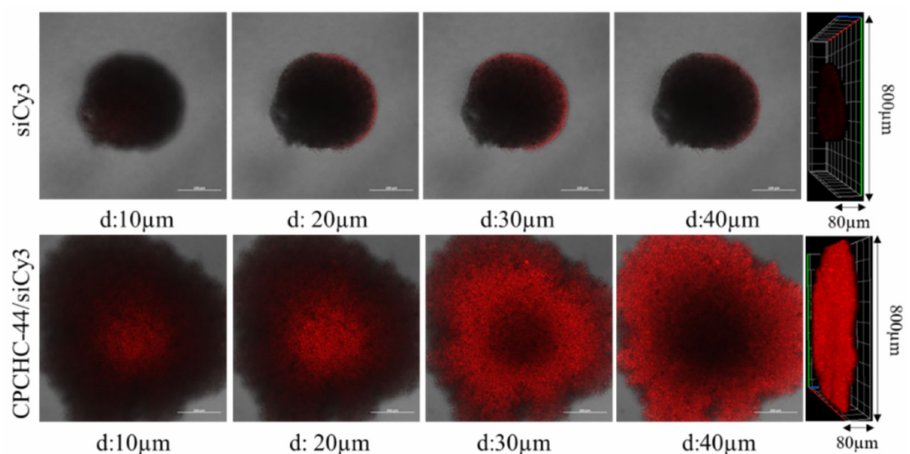
Figure 5. Confocal laser scanning microscopy mages of the 3D tumor spheroids incubated with the CPCHC-44/siCy3 NPs for 72 h. Scale bars: 200 µ m.